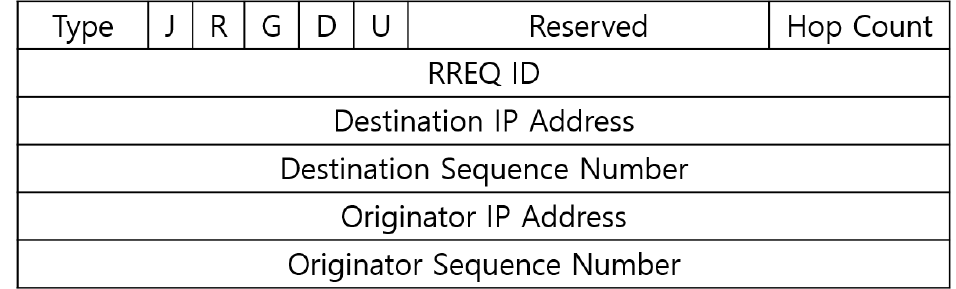
Figure 3. A branch node and the rank of each path in the network.